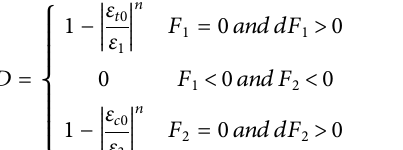
Frontiers in Earth Science |